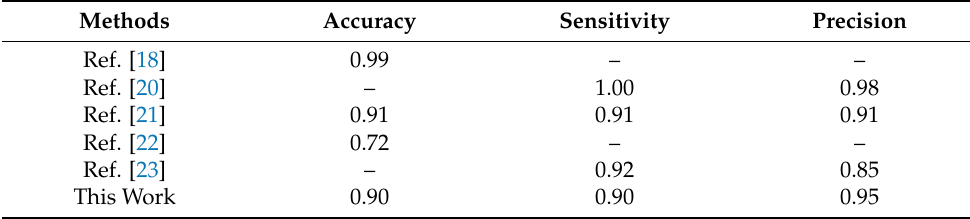
Table 2. The comparison between Kinect-camera-based methods and our method.